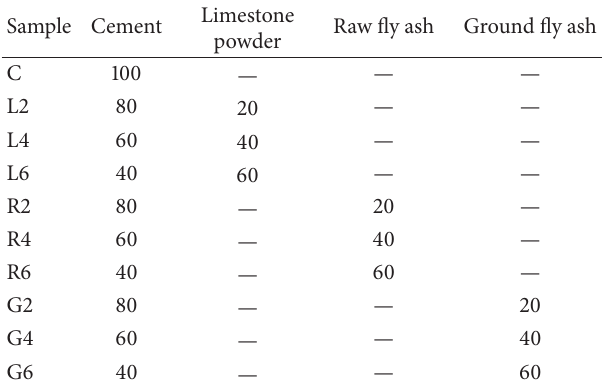
Table 3: Mix proportion of composite cementitious